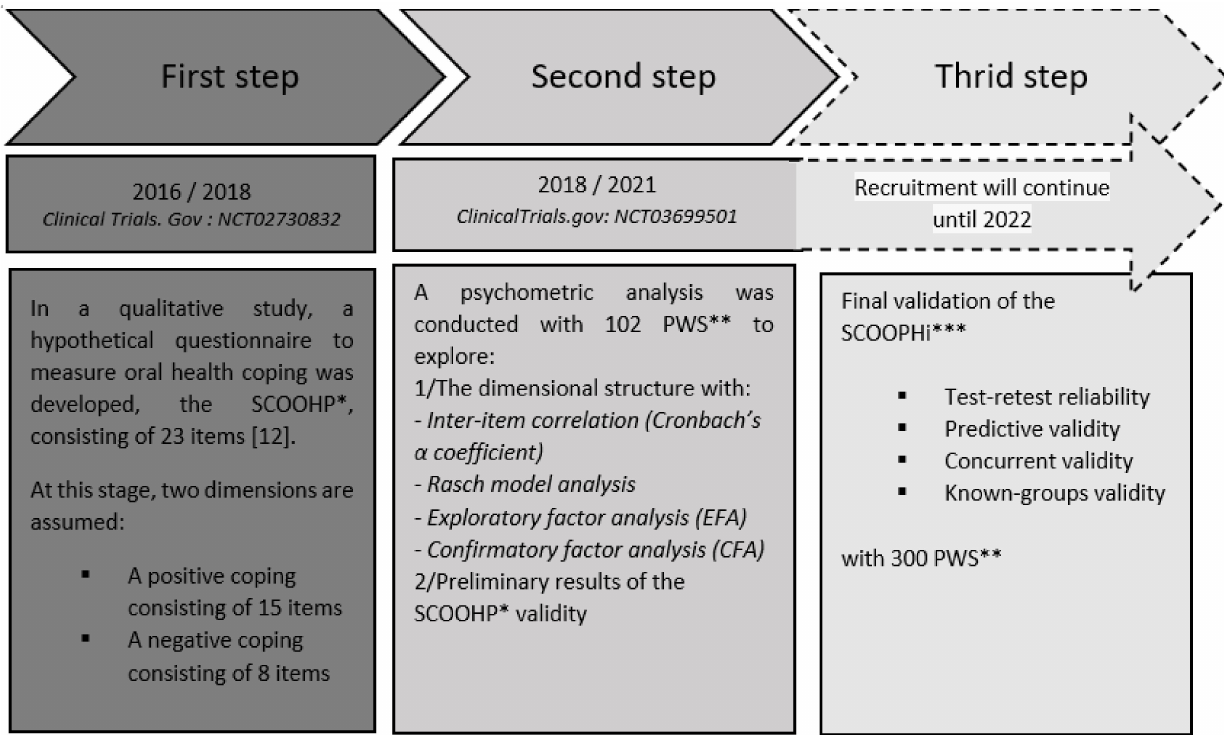
Figure 1. Flow chart of the study. SCOOHP*: Schizophrenia Coping Oral Health profile; PWS**: Persons with schizophrenia; SCOOHPI***: Schizophrenia Coping Oral Health profile and Index